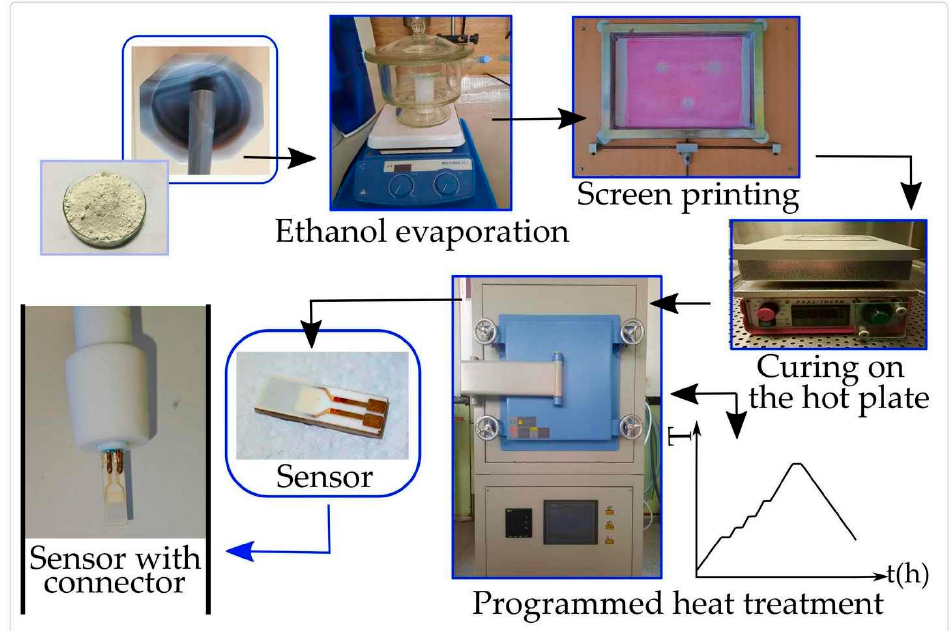
Figure 4. Schematic illustration of paste preparation and sensor fabrication.